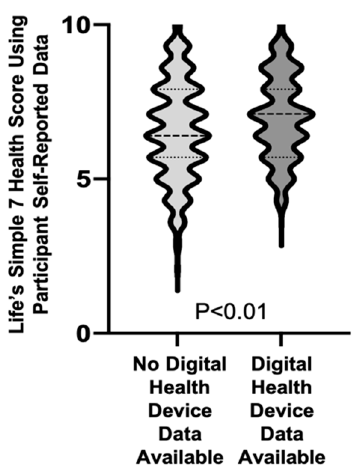
Figure 1. Life’s Simple 7 Health Score calculated using self-reported data for participants with and without registered digital health devices. The distribution of Life’s Simple 7 Health Scores is compared between individuals that did not register digital health devices ( n = 1171) and those that did register digital health devices ( n = 390) and presented as violin plots. The median and quartiles are denoted by dashed lines. Table 3. Life’s Simple 7 Health Score calculated from participant self-reported data.